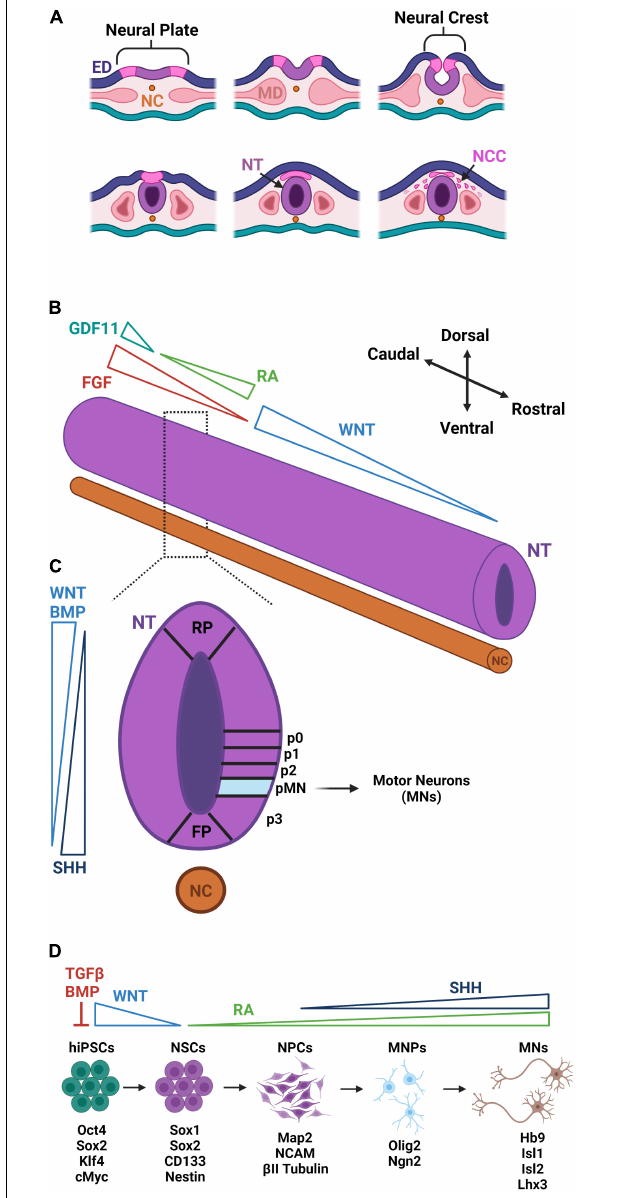
FIGURE 1 | Early development and hiPSC-based differentiation of motor neurons. (A) After the notochord (NC) signals inward folding of the ectoderm at the neural plate, the neural crest is brought together forming the neural tube (NT). The neural crest then forms neural crest cells (NCCs) which differentiate in the peripheral nervous system. The cells of mesoderm (MD) differentiate into somites and, eventually, the musculoskeletal system. (B) Along the rostral–caudal axis of the NT, WNT gradients dictate regionalization of the brain and RA/FGF/GDF11 gradients dictate segmentation of the spinal cord. (C) Along the dorsal–ventral axis of the NT, antithetical WNT/BMP [derived from the roof plate (RP)] and SHH gradients [derived from the floor plate (FP)] dictate patterning and the formation of the five ventral progenitor cell domains (p0, p1, p2, pMN, and p3). The pMN domain is the source of subsequent MN specification. (D) hiPSC-derivations of MNs begin with dual SMAD inhibition of TGF β and BMP pathways to trigger neural stem cell (NSC)